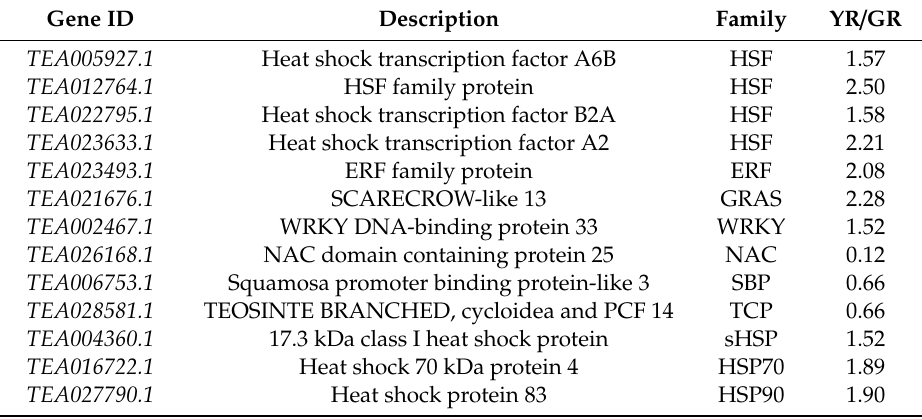
Table 2. Di ff erentially expressed TFs and heat shock proteins (HSPs) in the young shoots of YR and GR. Gene ID